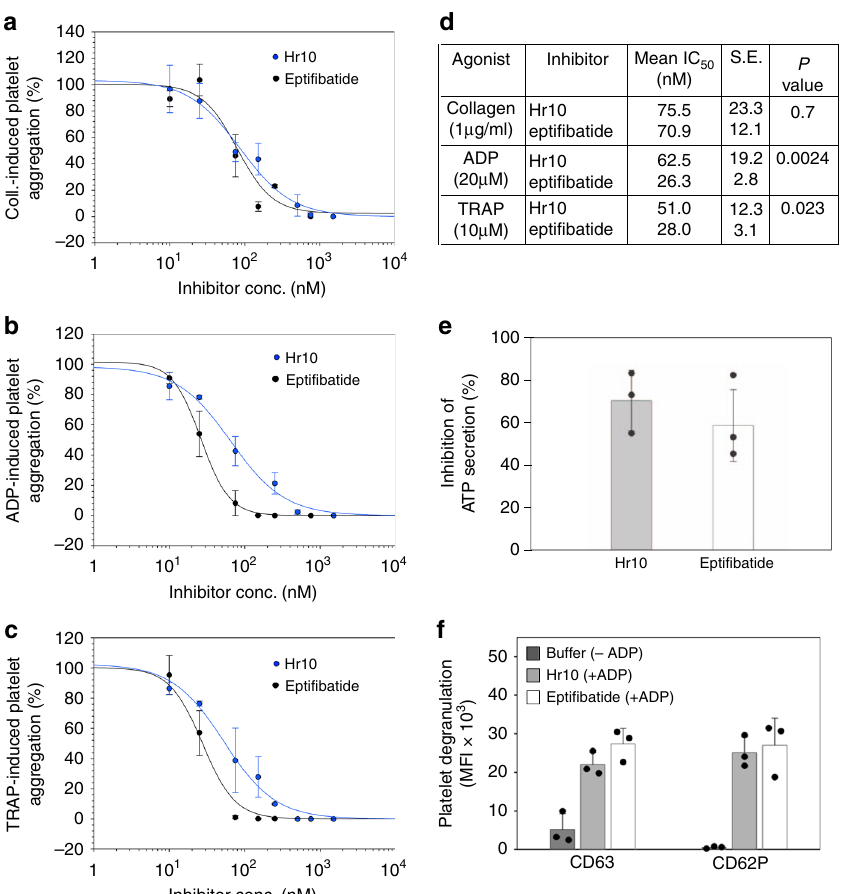
Fig. 4 Effect of Hr10 and epti fi batide on platelet aggregation and secretion. a – c Dose – response curves (mean + / − s.e., n = 3 experiments, each from a different donor) showing effects of the inhibitors on aggregation induced by collagen (Coll.) (2 μ g/ml) a , ADP (20 μ M) b , or TRAP (10 μ M) c . Points for the integrated impedance from the three experiments were individually normalized prior to averaging and are displayed with least-squares fi ts to the mean values. The respective IC 50 , s.e., and p values ( F -test, two-tailed) are listed in d . e – f Histograms (mean + or + / − s.d., n = 3 independent experiments) showing the effect of Hr10 and epti fi batide (each at 1.5 μ M) on ADP (20 μ M)-induced ATP secretion ( e , p = 0.41, Student ’ s t -test, two-tailed) and surface expression of CD63 and CD62P f on human platelets. No differences in expression of CD63 ( p = 0.15) or CD62P ( p = 0.72), both Student ’ s t -test, two- tailed, were found in platelets exposed to epti fi batide or Hr10. Buffer sample in f represents marker expression in the absence of